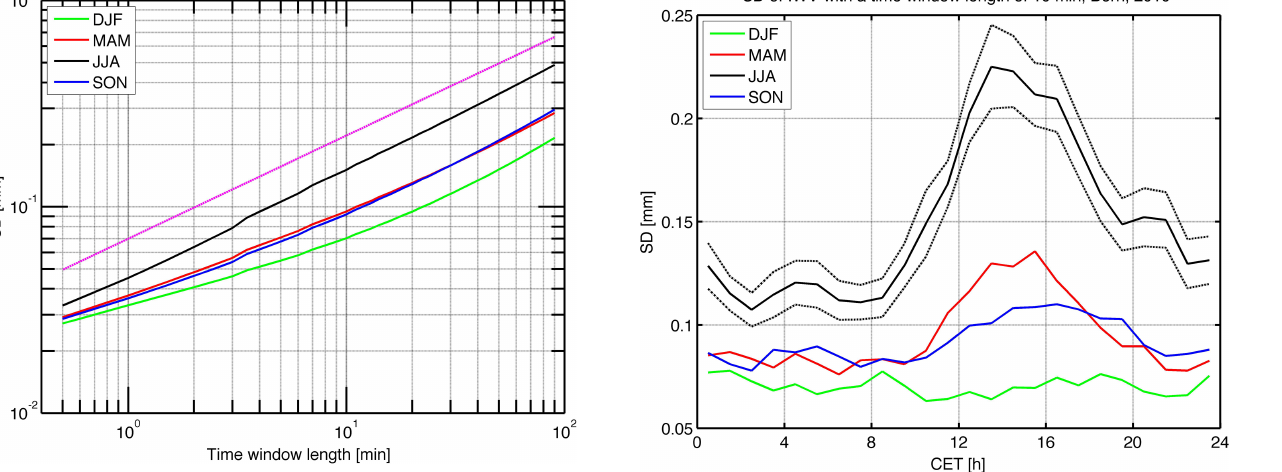
Figure 5. Diurnal cycle of IWV fluctuations observed at Bern for the four seasons of the year 2010 (moving standard deviation SD with a time window length of 10min). The green, red, blue, and black lines are for winter, spring, autumn, and summer respectively. CET stands for Central European Time (Universal Time + 1h). The error of the mean (for hourly averages) is shown for the summer season (JJA) by the dashed black lines.